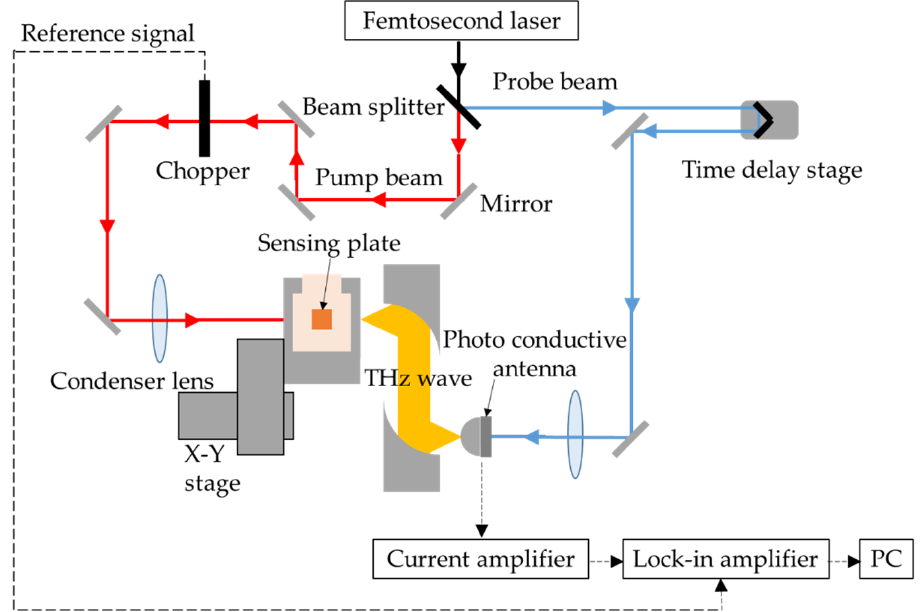
Figure 2. Optical system diagram of the TCM.